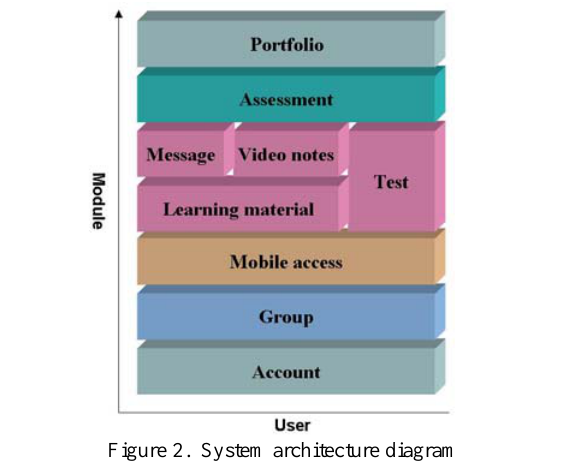
Figure 2. System architecture diagram